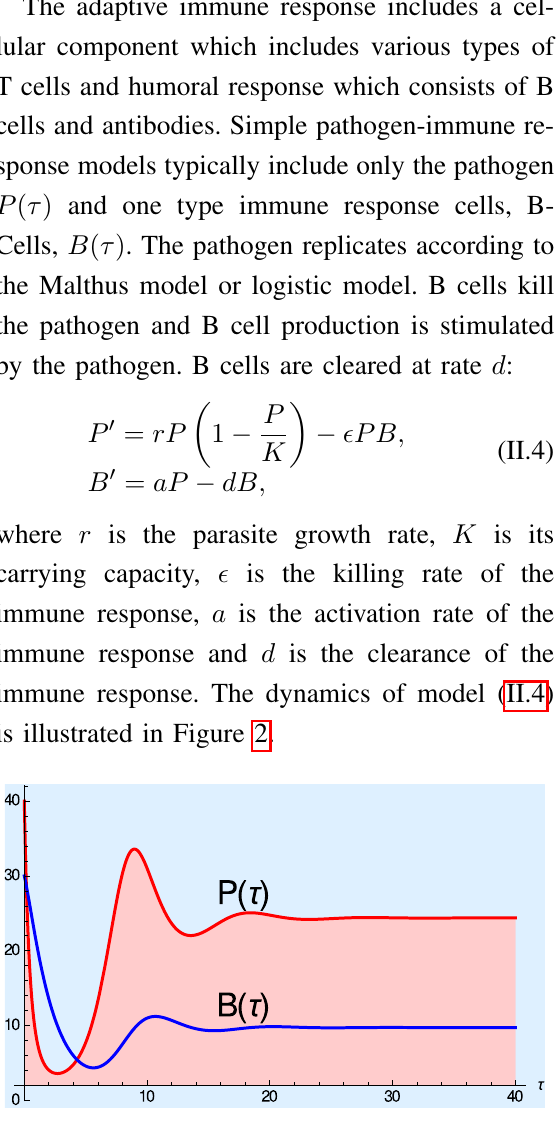
The dynamics of the pathogen and the immune response. Parameter values are r = 1 , K = 1000 , (cid:15) = 0 . 1 , a = 0 . 2